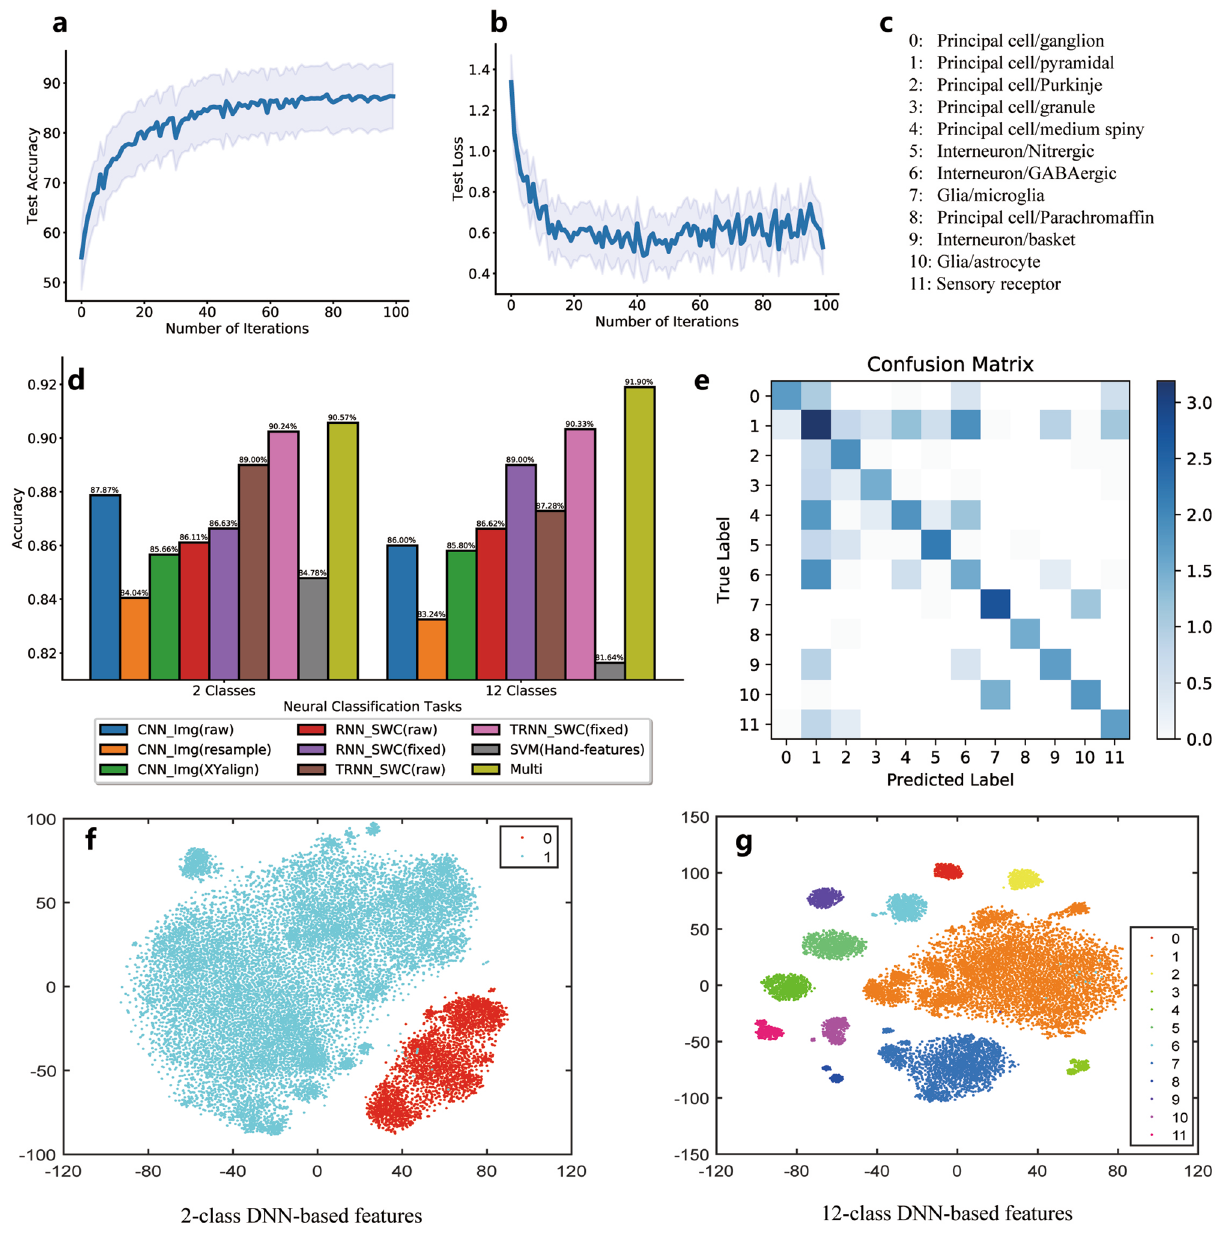
Figure 4. ( a ) The test accuracy with the number of iterations in the learning procedure of DNN-based neuron classification. ( b ) The loss curves in the test procedure of the DNN-based model. ( c ) The IDs and names of 12 subclasses of neuron types. ( d ) The performance of DNN-based models and other compared models on different types of datasets. ( e ) The confusion matrix, which shows the error classification in the 12-class identification. ( f ) The t-SNE distribution for the 2-class DNN-based features. ( g ) The t-SNE distribution for the 12-class DNN-based